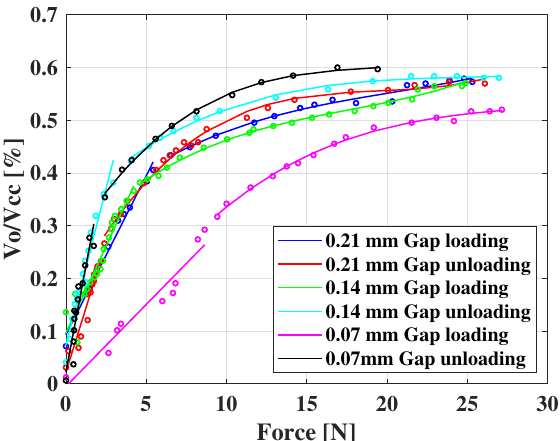
Figure 7. The calibration results of the FSUs with different numbers of layers. The comparison of our FSU against the commercial load cell (TAL220 Sparkfun Elec- tronics, Niwot, CO, USA) is illustrated in Figure 9, with the data from six repeated experi- ments, showing that the FSU measurements match the results obtained from the standard load cell with small deviations.